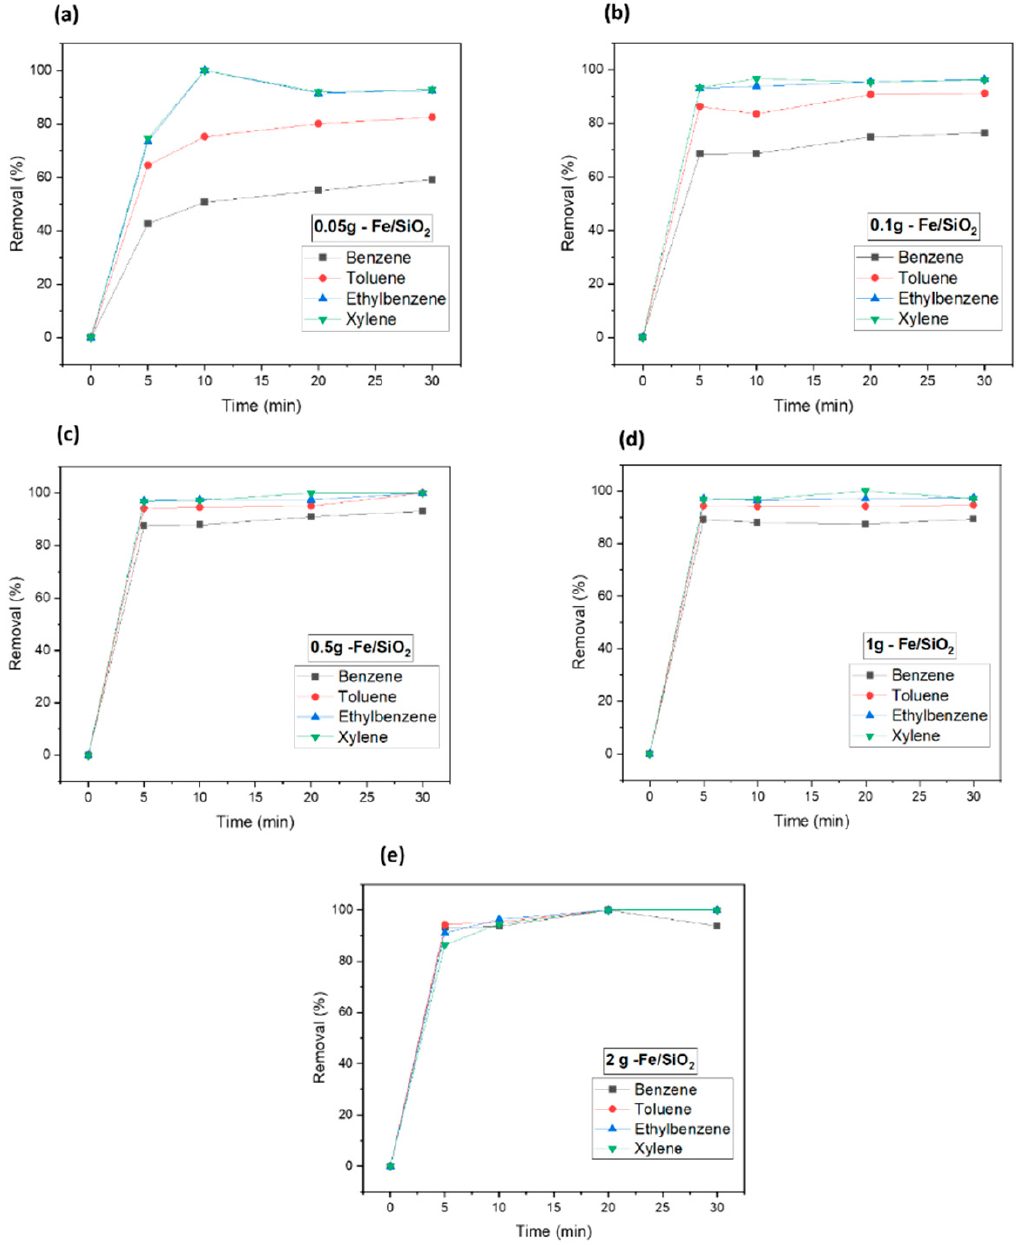
Figure 5. Catalyst dosage experiment for Fe/SiO 2 (Fe 2 O 3 /SiO 2 ) of nanocomposites. ( a ) 0.05 g—Fe/SiO 2 , ( b ) 0.1 g—Fe/SiO 2 , ( c ) 0.5 g—Fe/SiO 2 , ( d ) 1 g—Fe/SiO 2 , ( e ) 2 g—Fe/SiO 2